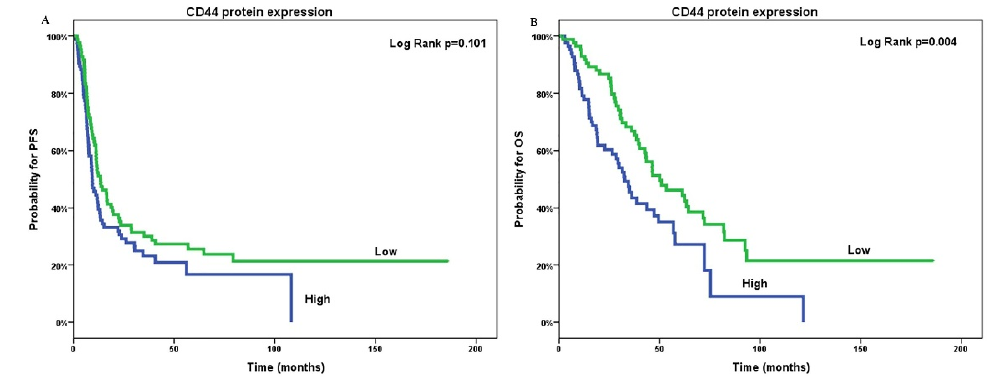
Figure 4. Correlation of tumoral CD44 protein expression ( A , B ) with overall survival (OS; A ) and progression-free survival (PFS; B ) of patients with epithelial ovarian cancer. OS: overall survival; PFS: progression-free survival.